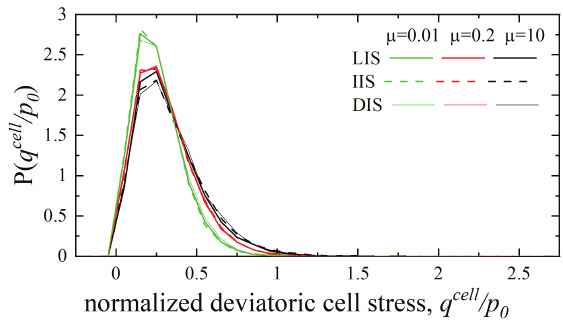
Fig. 5. PDFs of the deviatoric cell stress normalised by